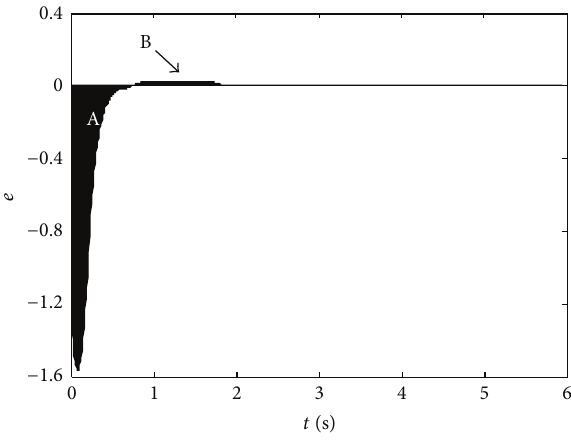
Figure 5: Curve of tracking error (controller B).